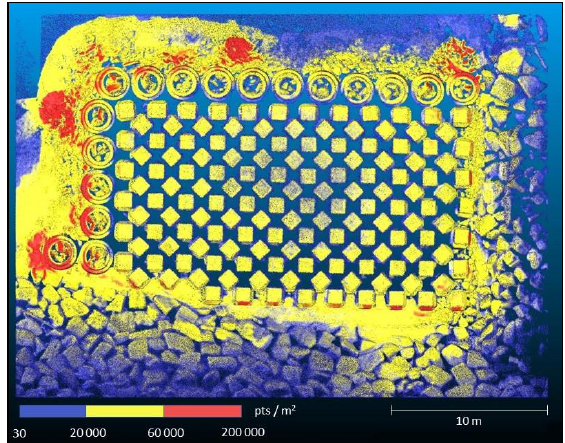
Figure 6. Surface point cloud density in